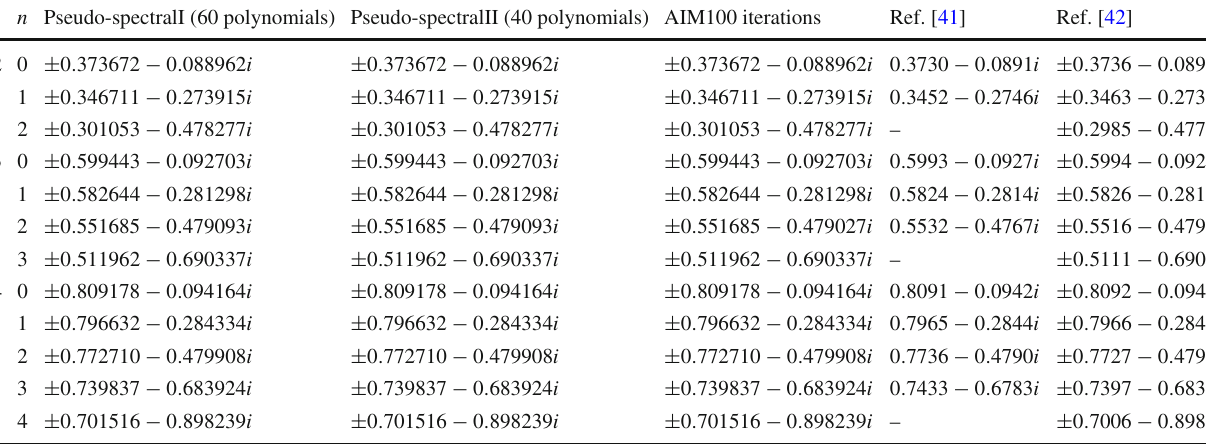
Table 3 Quasinormal frequencies of spin 2 perturbations normalized by the mass ( M ω) compared against the results of Refs. [41,42] l n Pseudo-spectralI (60 polynomials) Pseudo-spectralII (40 polynomials) AIM100 iterations